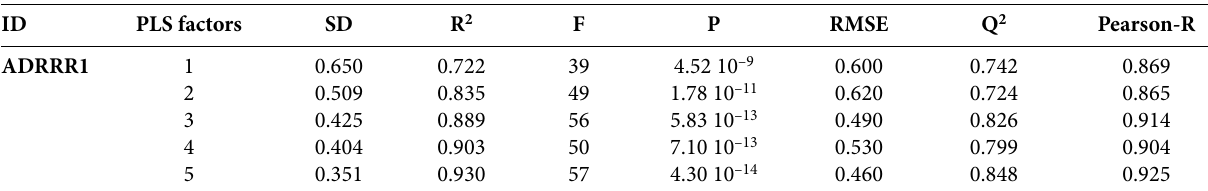
Table 3. 3D-QSAR PLS statistical results of the selected Pharmacophore model